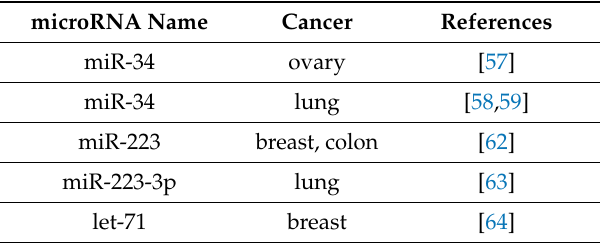
Table 2. MicroRNAs down-regulated by gain of function (GOF)